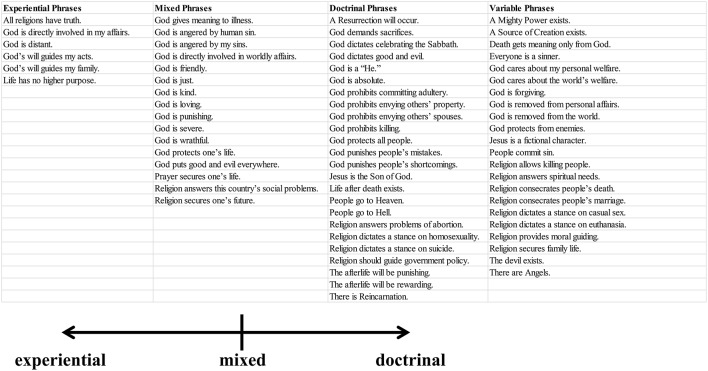
These are the 68 phrases from Kapogiannis et al. (2009b) and their ratings along a spectrum from experiential to doctrinal by religious studies scholars. Phrases in the mixed category were rated as equally experiential and doctrinal in nature by the religious studies scholars. Phrases in the variable category were inconsistently rated amongst scholars, and thus there was no consensus as to where they fit on the experiential to doctrinal spectrum.